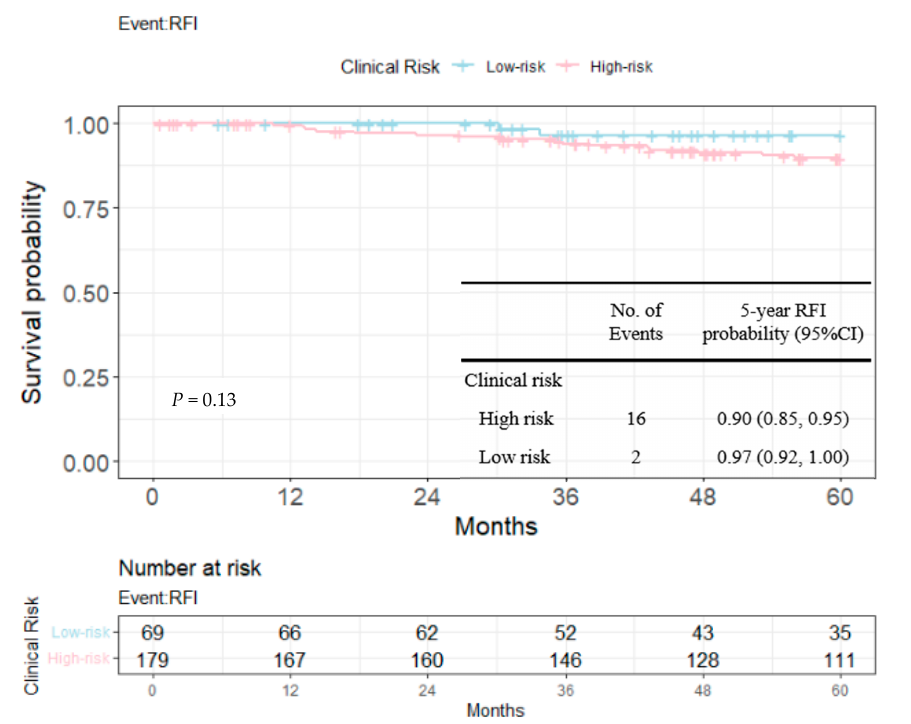
Cancers 2022 , 14 , x 11 of 19 Figure 4. Kaplan–Meier plot for RFI within 5 years to compare the partition of clinical risk. Blue: clinically low-risk group; red: clinically high-risk group.